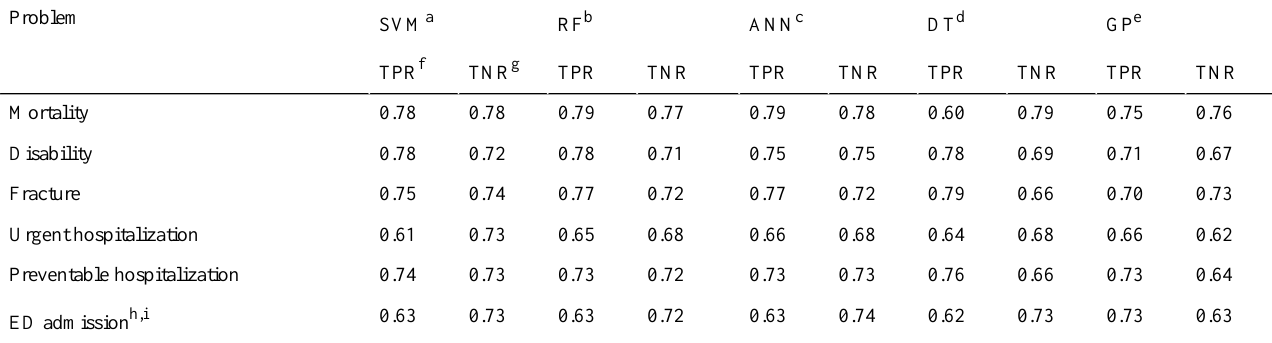
Table 3. Prediction performance using true positive rate and true negative rate for the six problems.